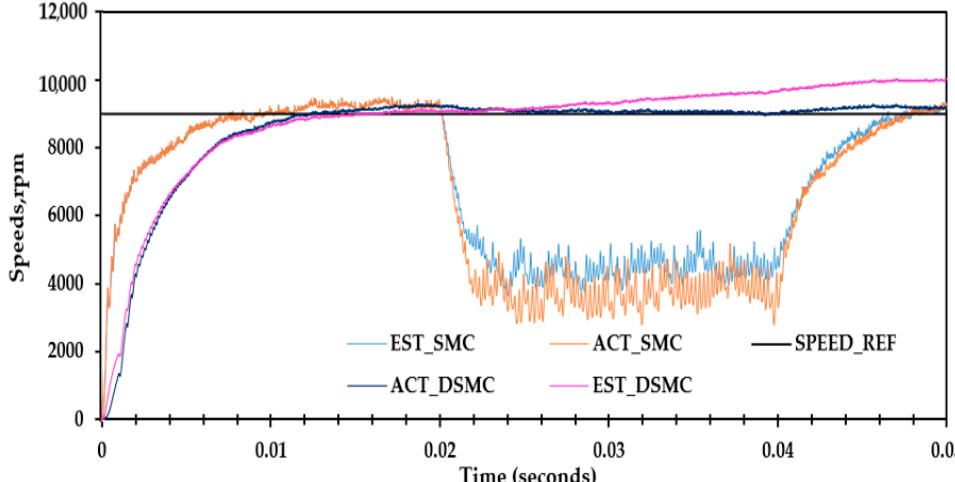
Figure 29. Change in the switching angle to 13 degrees. [Note: ACT_SMC: actual speed under sliding mode controller; EST_SMC: estimated speed under sliding mode controller; ACT_DSMC: actual speed under dynamic sliding mode controller; EST_DSMC: estimated speed under dynamic sliding mode controller; SPEED_REF: reference speed].